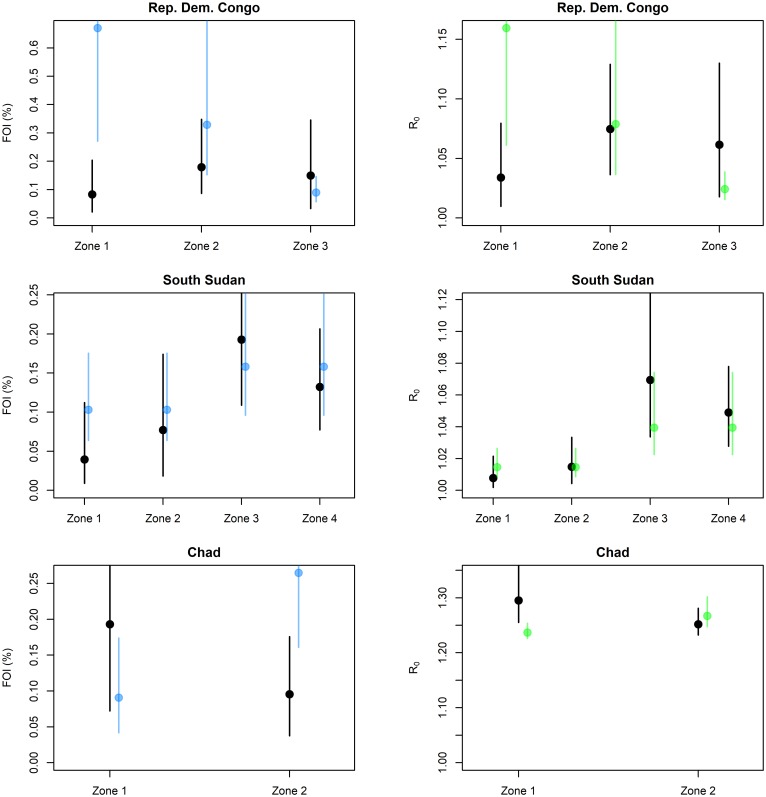
Comparison of directly estimated versus model-predicted transmission parameters for three external serological studies.Black: direct estimate; blue: prediction of the FOI model; green: prediction of the R0 model. Lines show 95% credibility intervals.